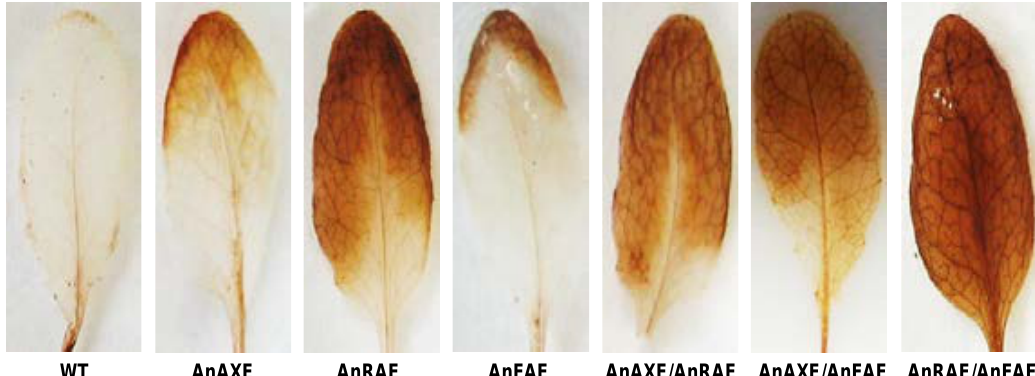
Figure 5. Detection of H 2 O 2 accumulation in uninfected healthy transgenic plants. DAB staining assay was carried out on uninfected three-week-old WT and transgenic leaves (representative images shown).